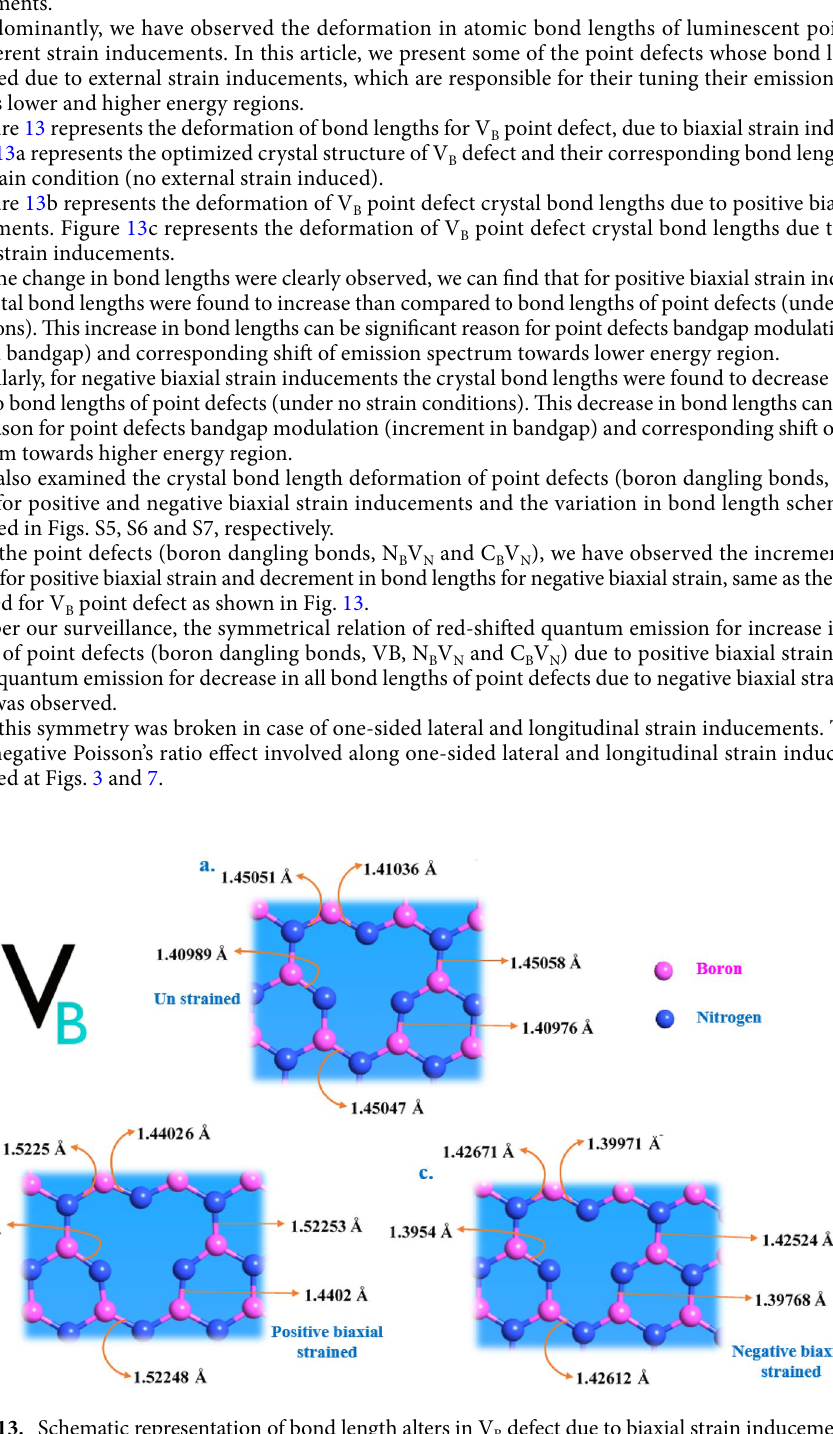
Figure 13. Schematic representation of bond length alters in V B defect due to biaxial strain inducement. ( a ) Optimized V B point defect and their corresponding bond lengths measured under no external inducement condition. ( b , c ) V B point defects and their altered bond lengths measured under positive and negative biaxial strain inducements, respectively. The bond lengths found incremented for positive biaxial strain and decremented for negative biaxial strain inducements, compared to bond lengths of point defect under no strain condition as shown in ( a ). The % of positive and negative strain applied to the V B defect was listed in Table